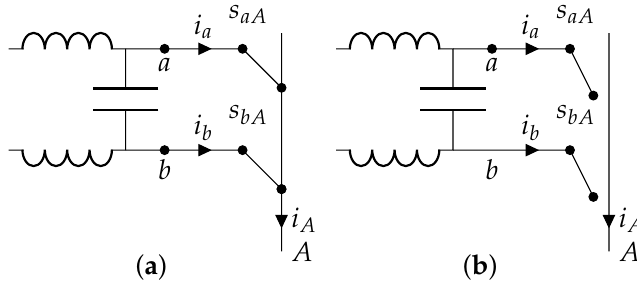
Figure 3. BDS issues in the Matrix Converter (MC): ( a ) short-circuit and ( b ) open-circuit.